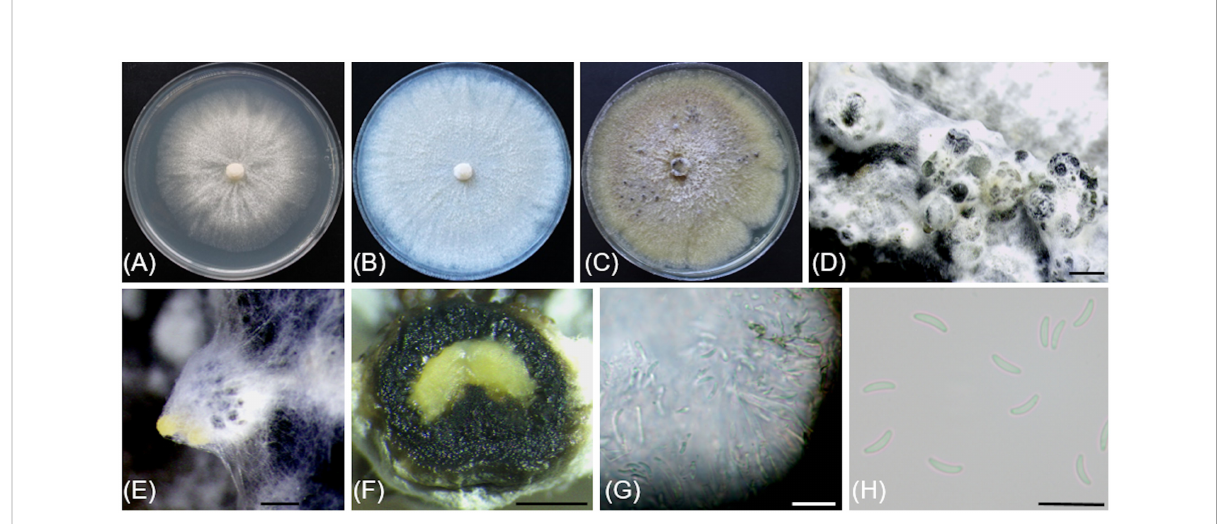
FIGURE 5 Cytospora macropycnidia (CBS 149338/Kern907). (A) 4-day-old culture on 2% PDA. (B) 7 - day-old culture on 2% PDA. (C) 32-day-old culture on 3.5% PDA. (D) Gregarious pycnidia produced in vitro on sterile grapevine wood. (E) Solitary pycnidium exudating pale yellow cirrhus (mucilage). (F) Longitudinal section of a pycnidium. (G) Conidiogenous cells and conidia. (H) Conidia. Scale bars: 1mm (D – F) ; 10µm (G, H)